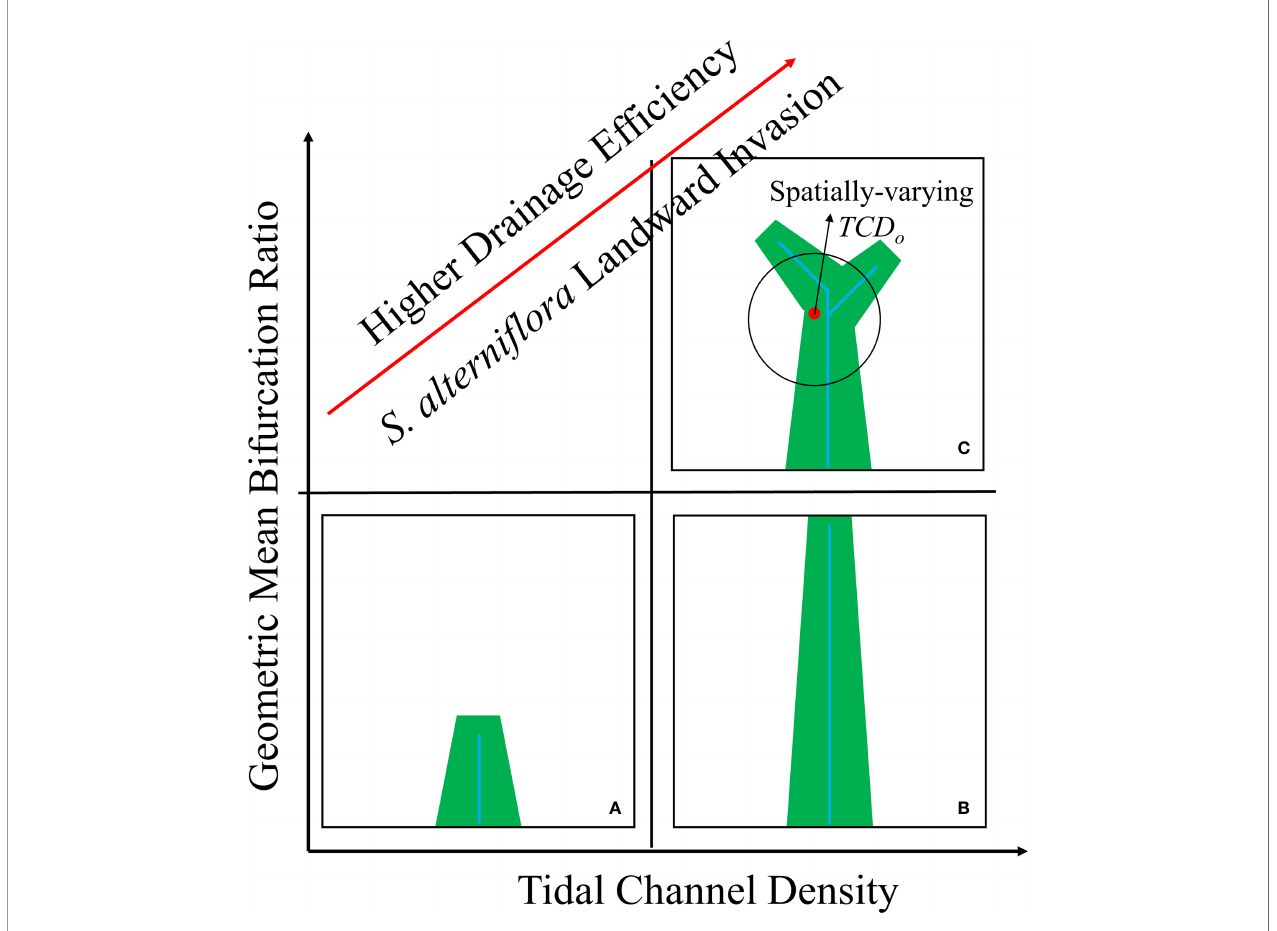
FIGURE 10 | Metric framework on how tidal channel networks mediate S. alterni fl ora landward invasion in the marsh-channel system. (A) Low tidal channel density; (B) High tidal channel density with low geometric mean bifurcation ratio; (C) High tidal channel density with high geometric mean bifurcation ratio. Blue colour shows the tidal channel network, while the green colour is the vegetation